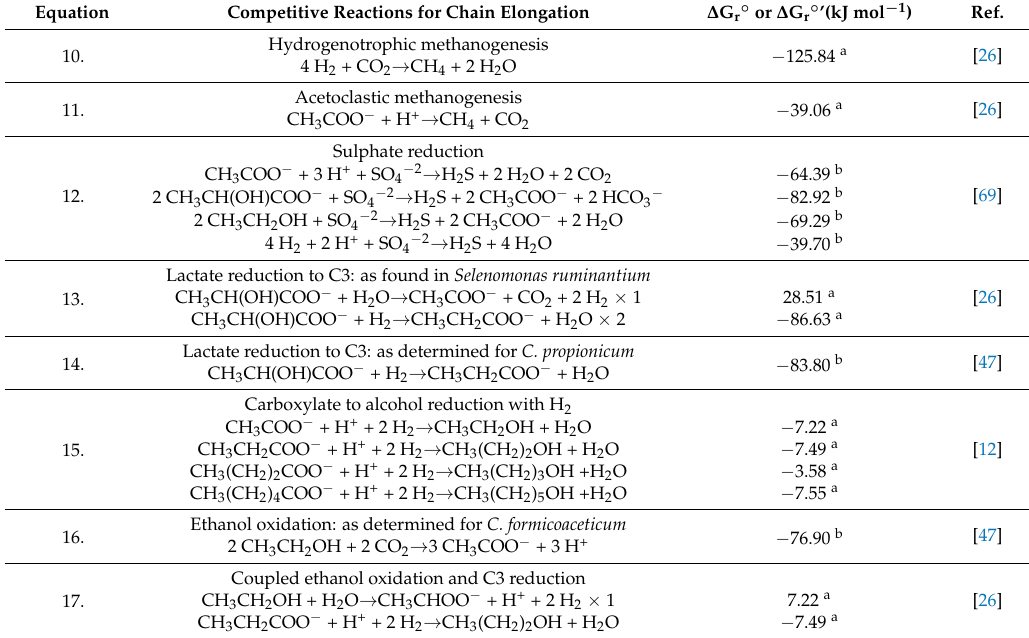
Table 2. Biochemical reactions that compete with chain elongation and their thermodynamic information with concentrations and pressures of all components at 1 M or 1